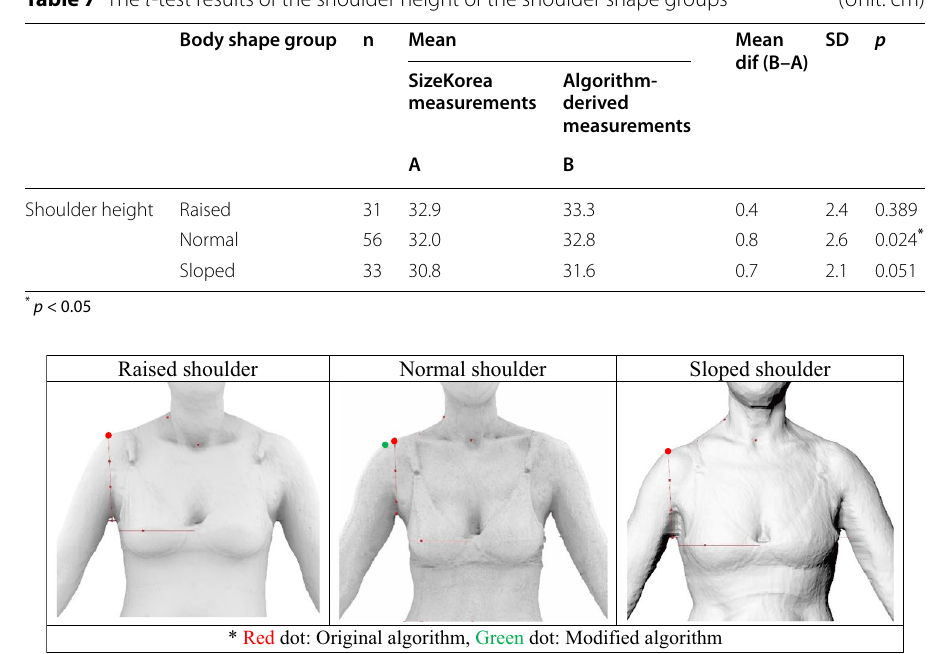
Fig. 6 The shoulder points identified by the